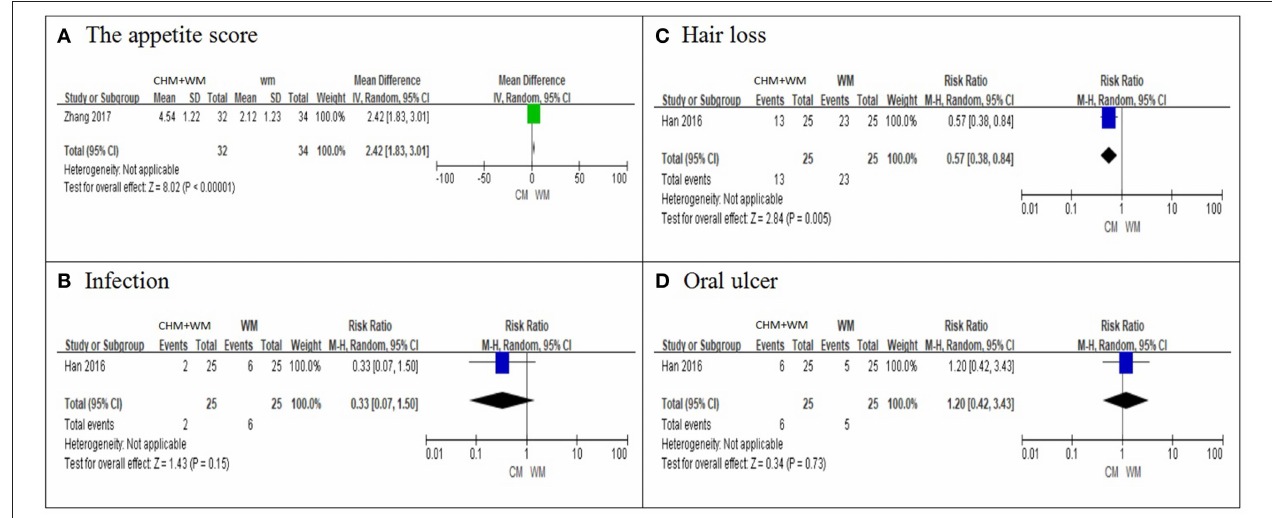
FIGURE 4 | Other results. (A–D) shown the comparisons and meta-analysis on the appetite score, hair loss, infection and oral ulcer between CHM-WM group and WM group. The I2 statistic described the percentage of total variation across studies that was due to heterogeneity rather than chance. CI indicated the confidence interval. Dichotomous data were presented as pooled Risk Ratio (RR) with 95% confidence intervals (95% CIs), while continuous data were presented as Mean Difference (MD) with 95%